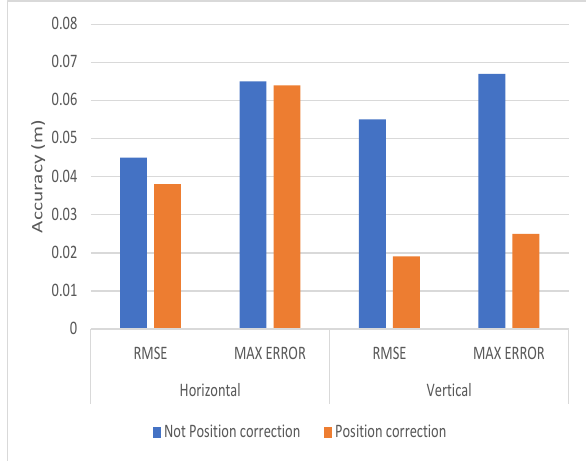
Figure3. Verification Results of positional Accuracy